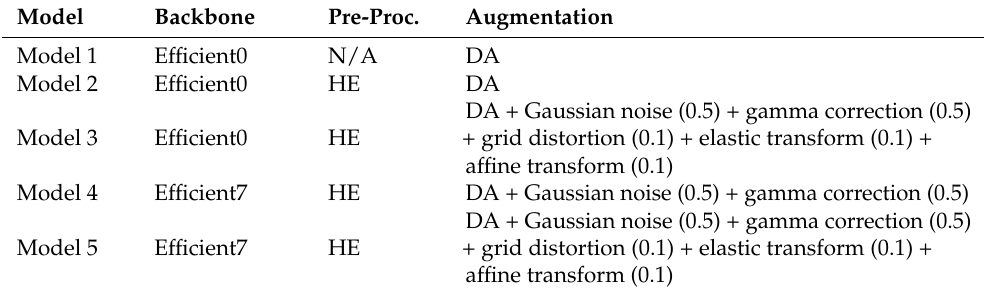
Table 1. Conditions for training different segmentation models.